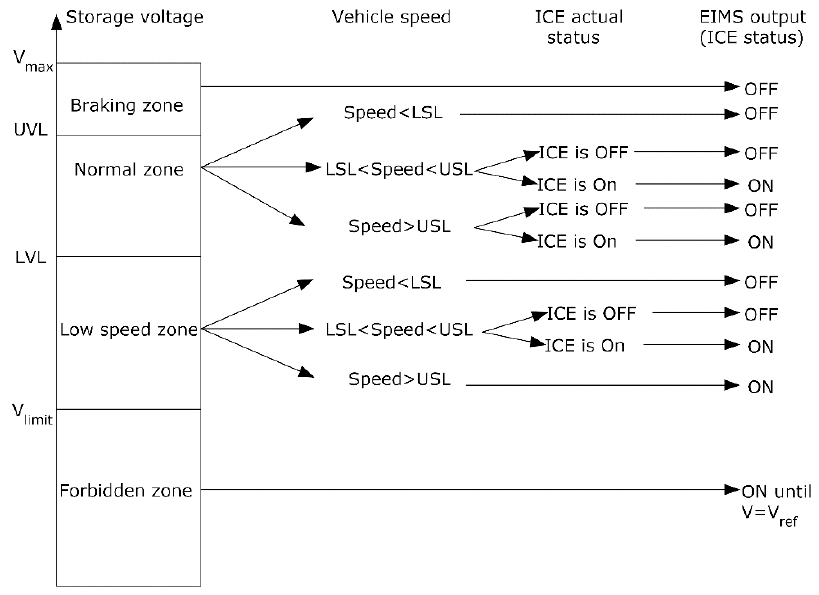
Figure 3. Engine Power Management System (EPMS).